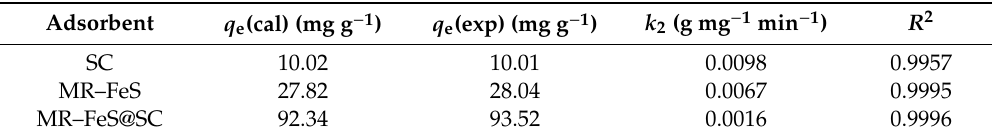
Table 2. Pseudo-second-order kinetic parameters for the adsorption of ST by di ff erent adsorbents. Table 2. Pseudo ‐ second ‐ order kinetic parameters for the adsorption of ST by different adsorbents.